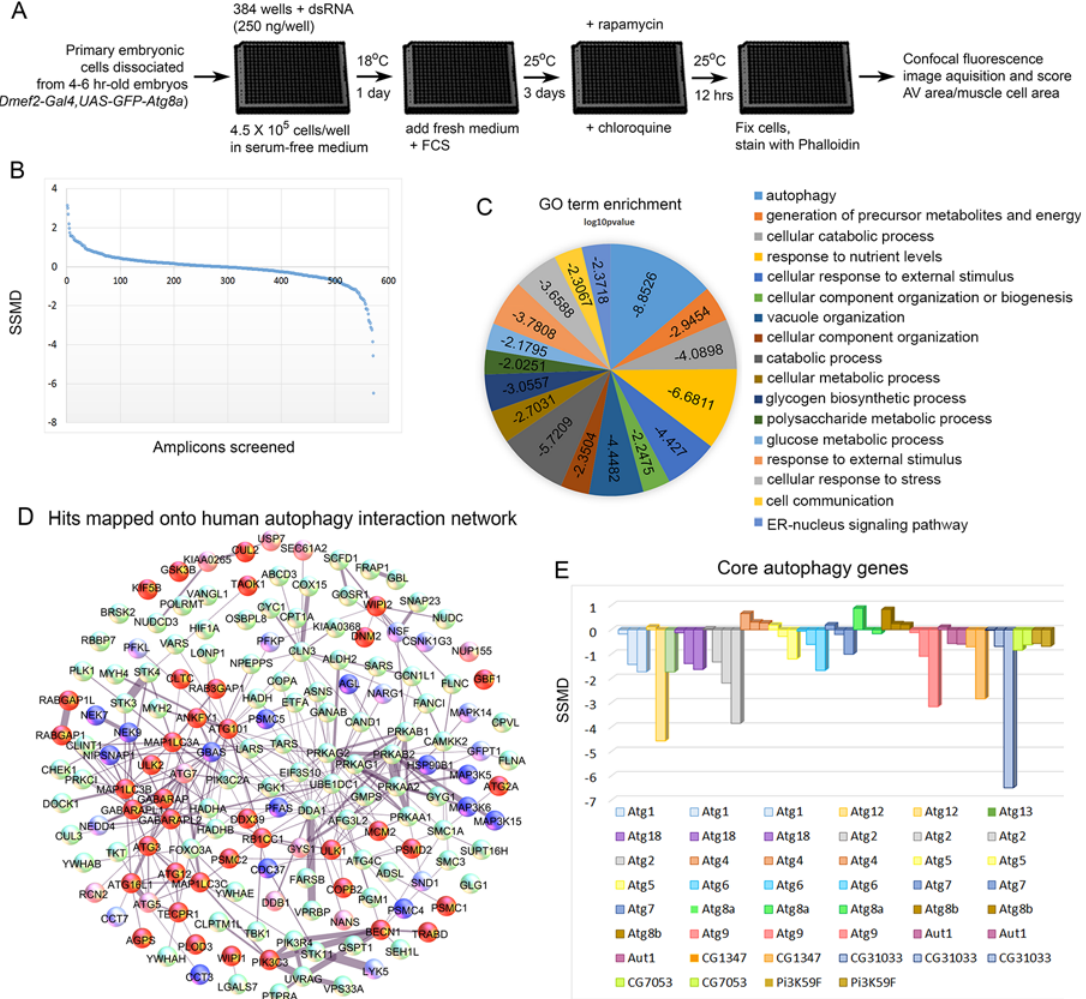
Fig 2. Screen of D. melanogaster autophagosome network orthologs identifies genes essential for autophagy in skeletal muscles. A) Outline of the RNAi screen in primary cultured muscles. B) Results of RNAi knockdown screen on autophagic vesicle area/primary muscle cell area. Y-axis is the strictly standardized mean difference (SSMD) scores for each amplicon tested (X-axis). C) GO term enrichment (biological process) of human orthologs hits. Scores on pie chart indicate the log10 p-value of enrichment. D) Hits mapped onto the 187 human genes used as the basis for screening in D. melanogaster . Protein- protein interactions were identified from the set of 409 proteins identified in mammalian cells[16]. For gene knockdowns that inhibited autophagy, dark red indicates that two amplicons had a score < -0.5, while light red indicates that only one amplicon had a significant SSMD score, but that it was < -1. For gene knockdowns that increased autophagy, dark blue indicates that two amplicons had an SSMD score > 0.5, while light blue indicates that only one amplicon had a significant SSMD score, but that it was > 1. (E) At least one amplicon scored as a hit for each of the core autophagy genes tested, with the exception of Atg8 , which is our marker for autophagy and is being overexpressed with Dmef2-Gal4 , and Atg4 .